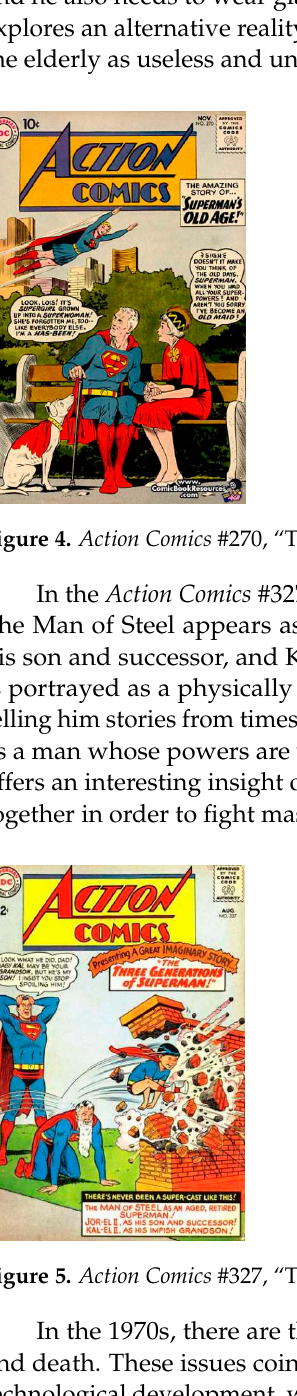
Figure 3. Action Comics #251, “The Oldest Man in Metropolis” (April 1959) [10] .